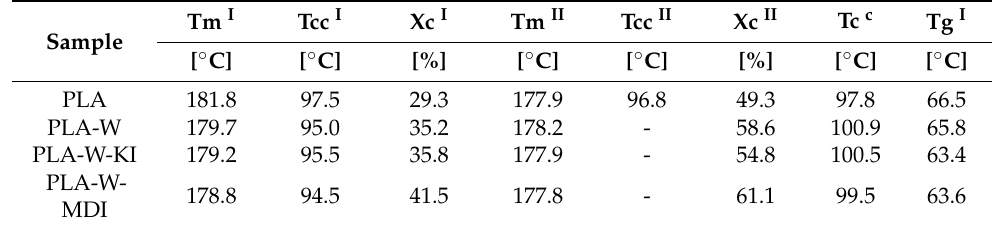
Figure 10. DSC heating and cooling curves of PLA and PLA-W composites. Table 1. Thermal parameters obtained for PLA and PLA-based composites obtained from DSC.